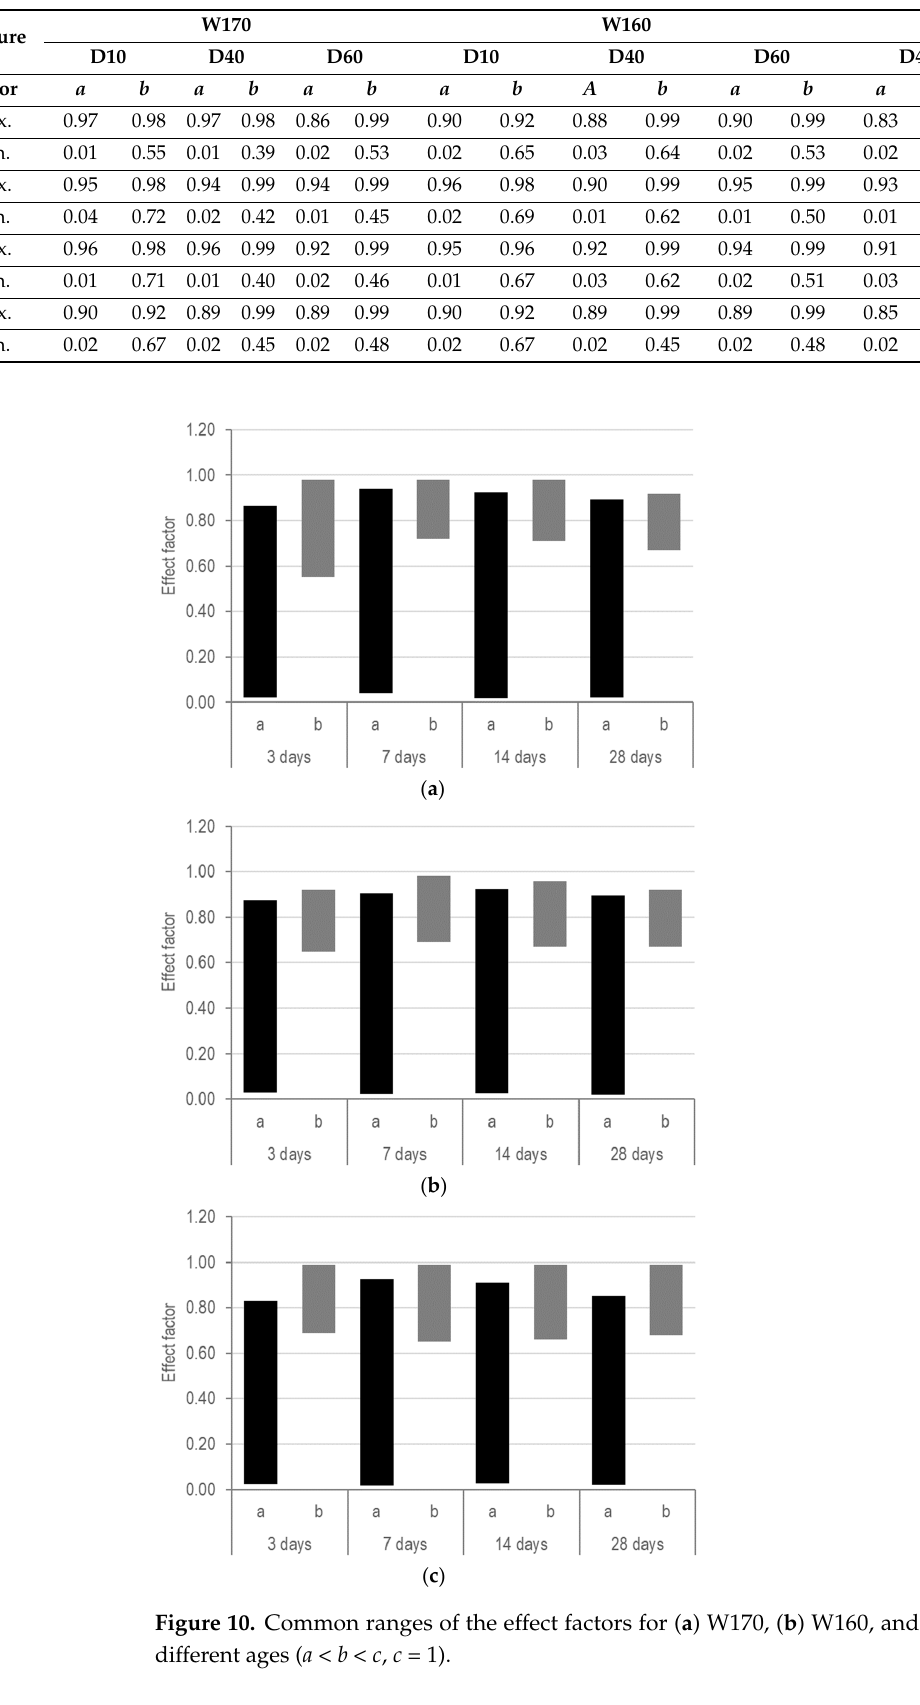
Table 4. Results of the calculated aggregate effect factors ( a < b < c , c = 1).